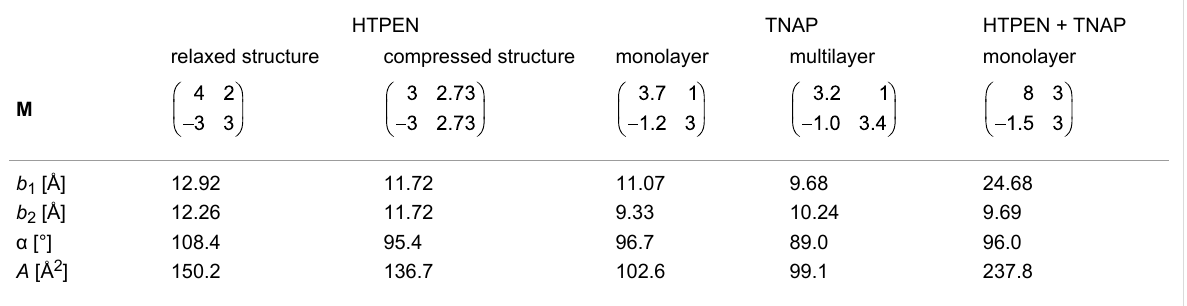
Table 1: Overview of the superstructures considered here. M denotes the superstructure matrix of the overlayer, b 1 , b 2 denote the lengths of the unit cell vectors of the superstructure, α is the enclosed angle, and A is the area of the unit cell. The error of the integer matrix elements is smaller than 0.03.